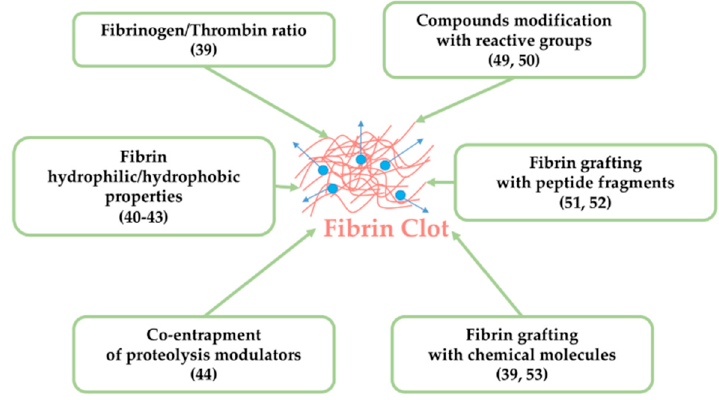
Figure 4. Fibrin and active agents handling for compounds delivery.